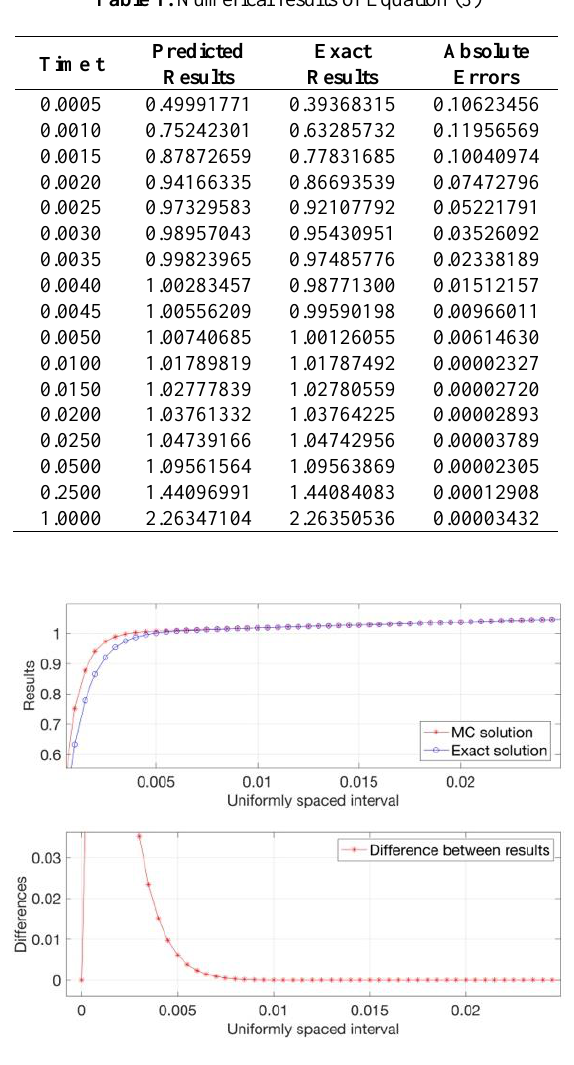
Figure 2. A closer view of Figure